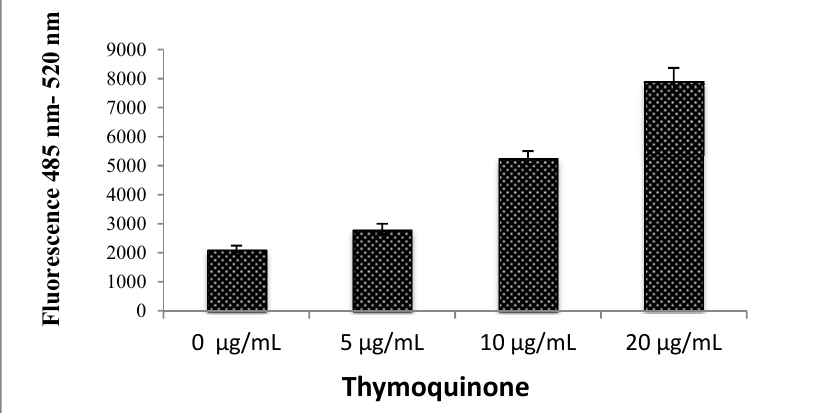
Figure 9. Effect of thymoquinone treatment on ROS generation. ROS concentration was determined by treating CEMss cells with 0, 5, 10 and 20 μ g/mL TQ, the cells were loaded with DCFH-DA, and the fluorescence was measured by a fluorescence micro plate